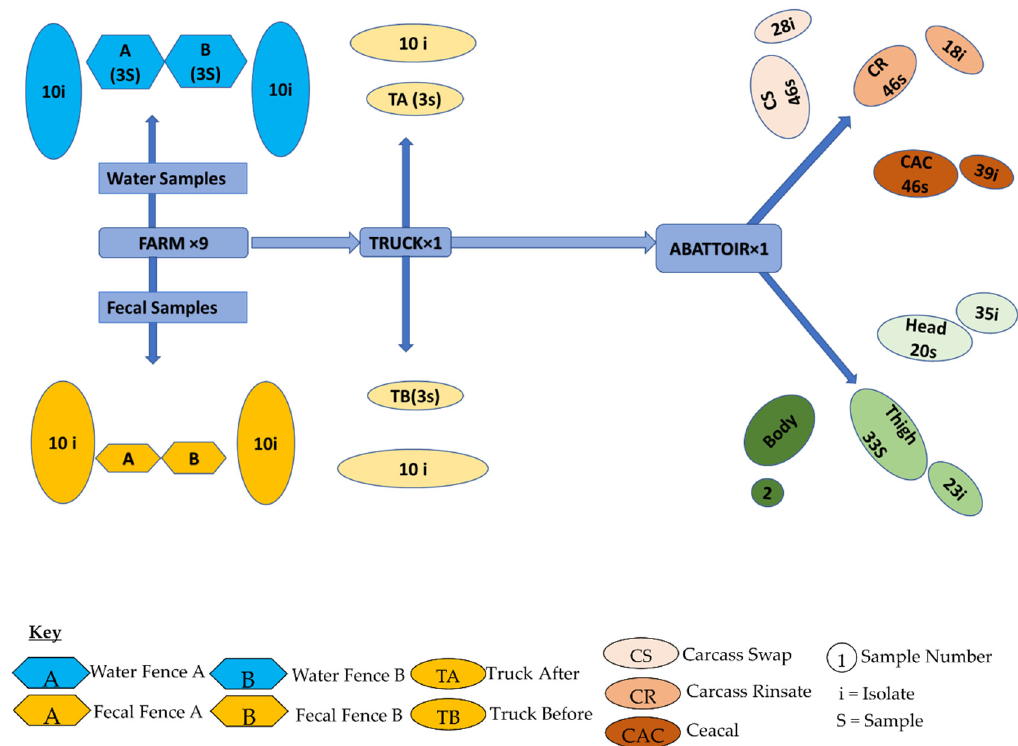
Figure 5. A flow diagram depicting the sampling frame used in the farm-to-fork approach.